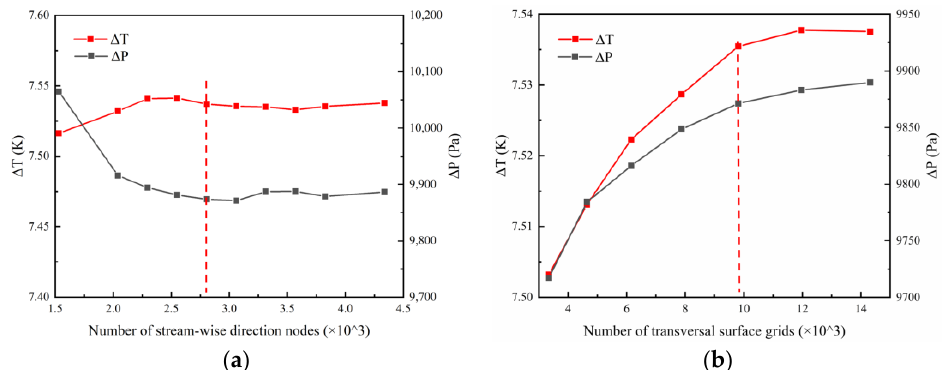
Figure 3. Mesh independence verification at R32 case in the stream-wise direction ( a ) and transversal surface ( b ).